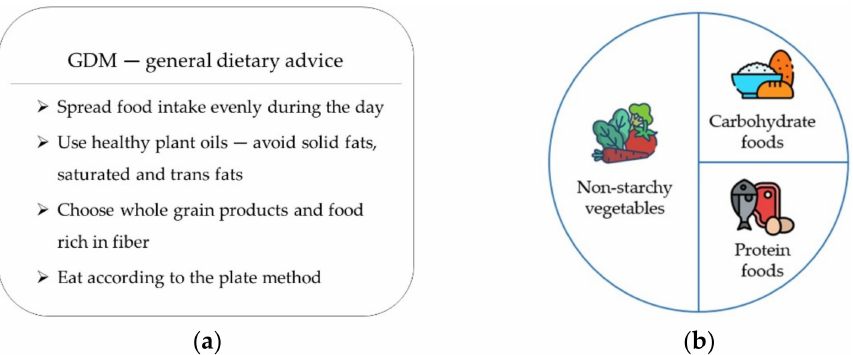
Figure 1. Dietary advice for women with gestational diabetes mellitus (GDM): ( a ) general dietary advice; ( b ) the plate